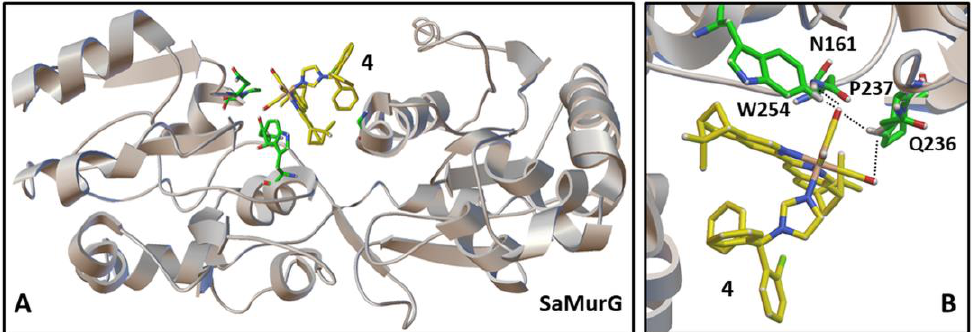
Figure 6. Full ( A ) and detail ( B ) view of the binding region of computer-generated lowest energy pose of complex 4 in SaMurG homology model.